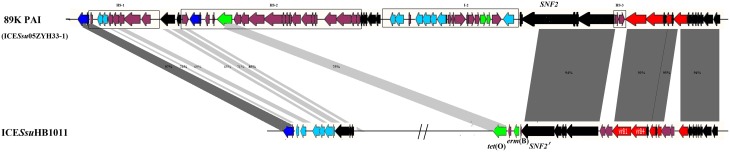
ORF map of ICESsuHB1011 to the 89K PAI (ICESsu05ZYH33-1) of S. suis 05ZYH33. 89K PAI (ICESsu05ZYH33-1) was proved to be a pathogenicity island response for the human S. suis Outbreak in Sichuan, China in 2005. Genes are shown in different colors: black, ICEs core genes; navy, int and xis; azure, nisin operon genes; red, T4SS genes; green, antibiotic and heavy metal resistance genes.